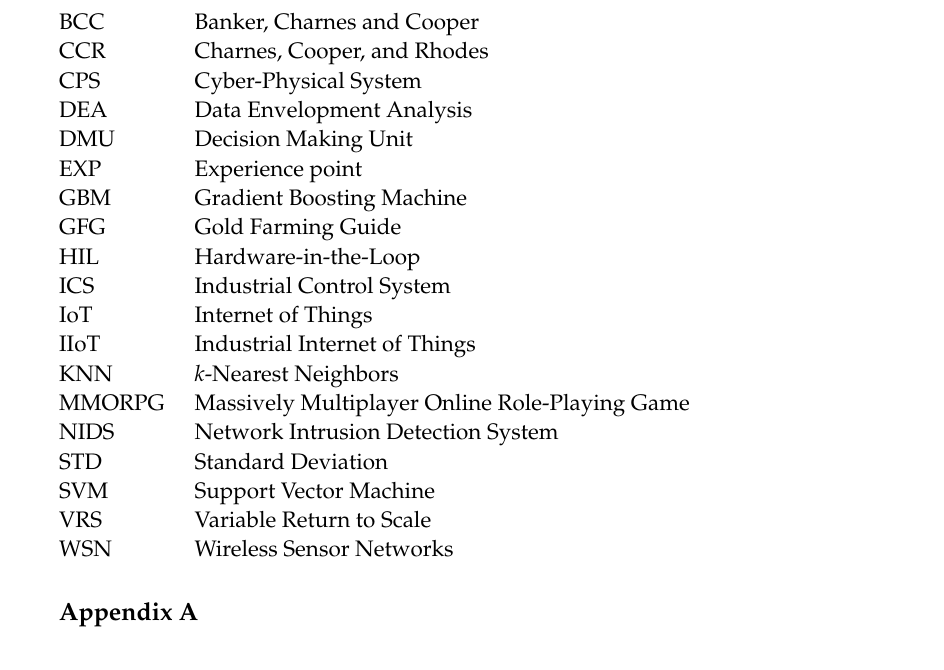
Table A1. This appendix shows the results of measuring the DEA method using pyDEA, for which we applied the output-oriented VRS model. The detailed values are shown in Figure